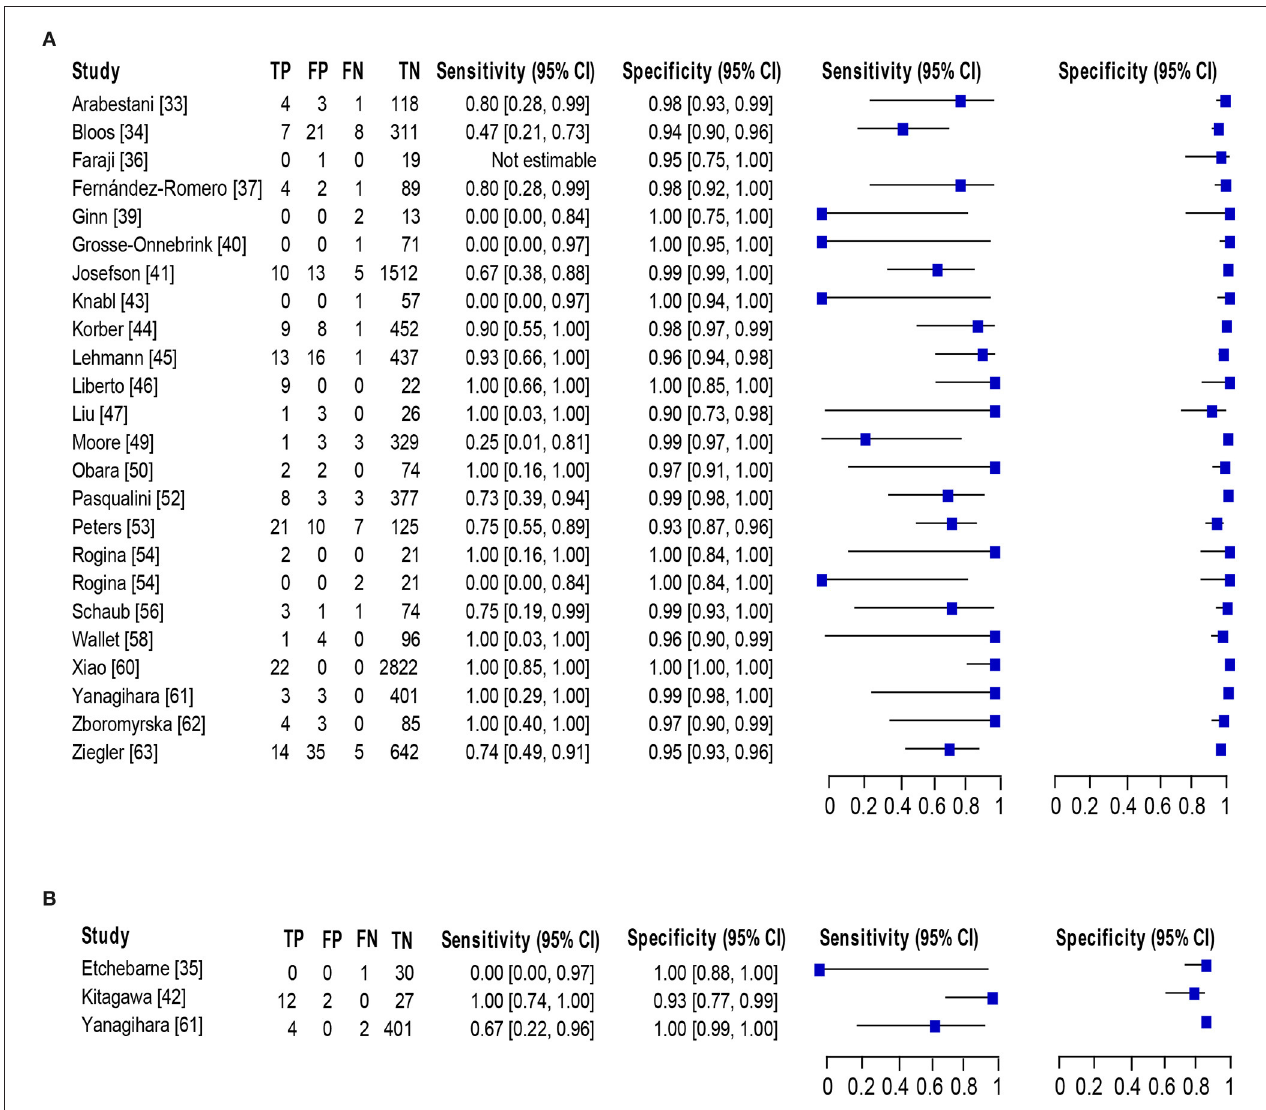
FIGURE 4 | Forest plot for detection of (A) MSSA and (B) MRSA in the adult population. The square stands for the sensitivity and specificity of a particular study, the black line represents its confidence interval. TP, true positive, FP, false positive, FN, false negative, TN, true negative, CI, confidence interval.